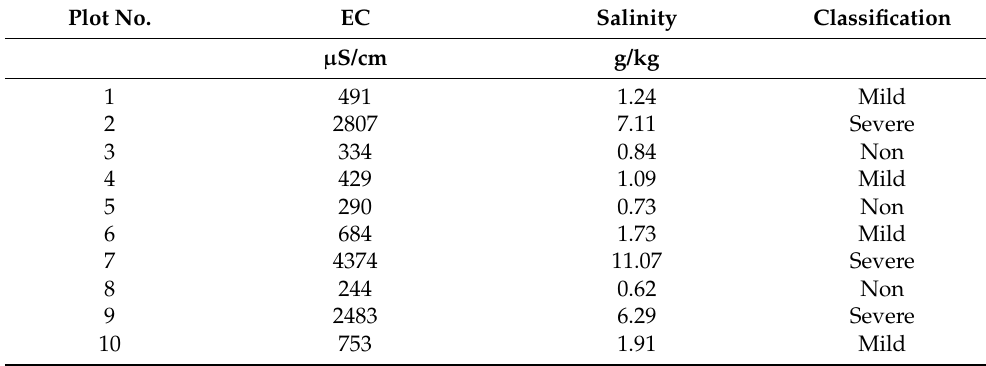
Table 1. Electrical conductivity (EC), calculated salinity and soil classification of 10 plots from Sino–Czech–Slovak Friendship Farm. Plot No. EC